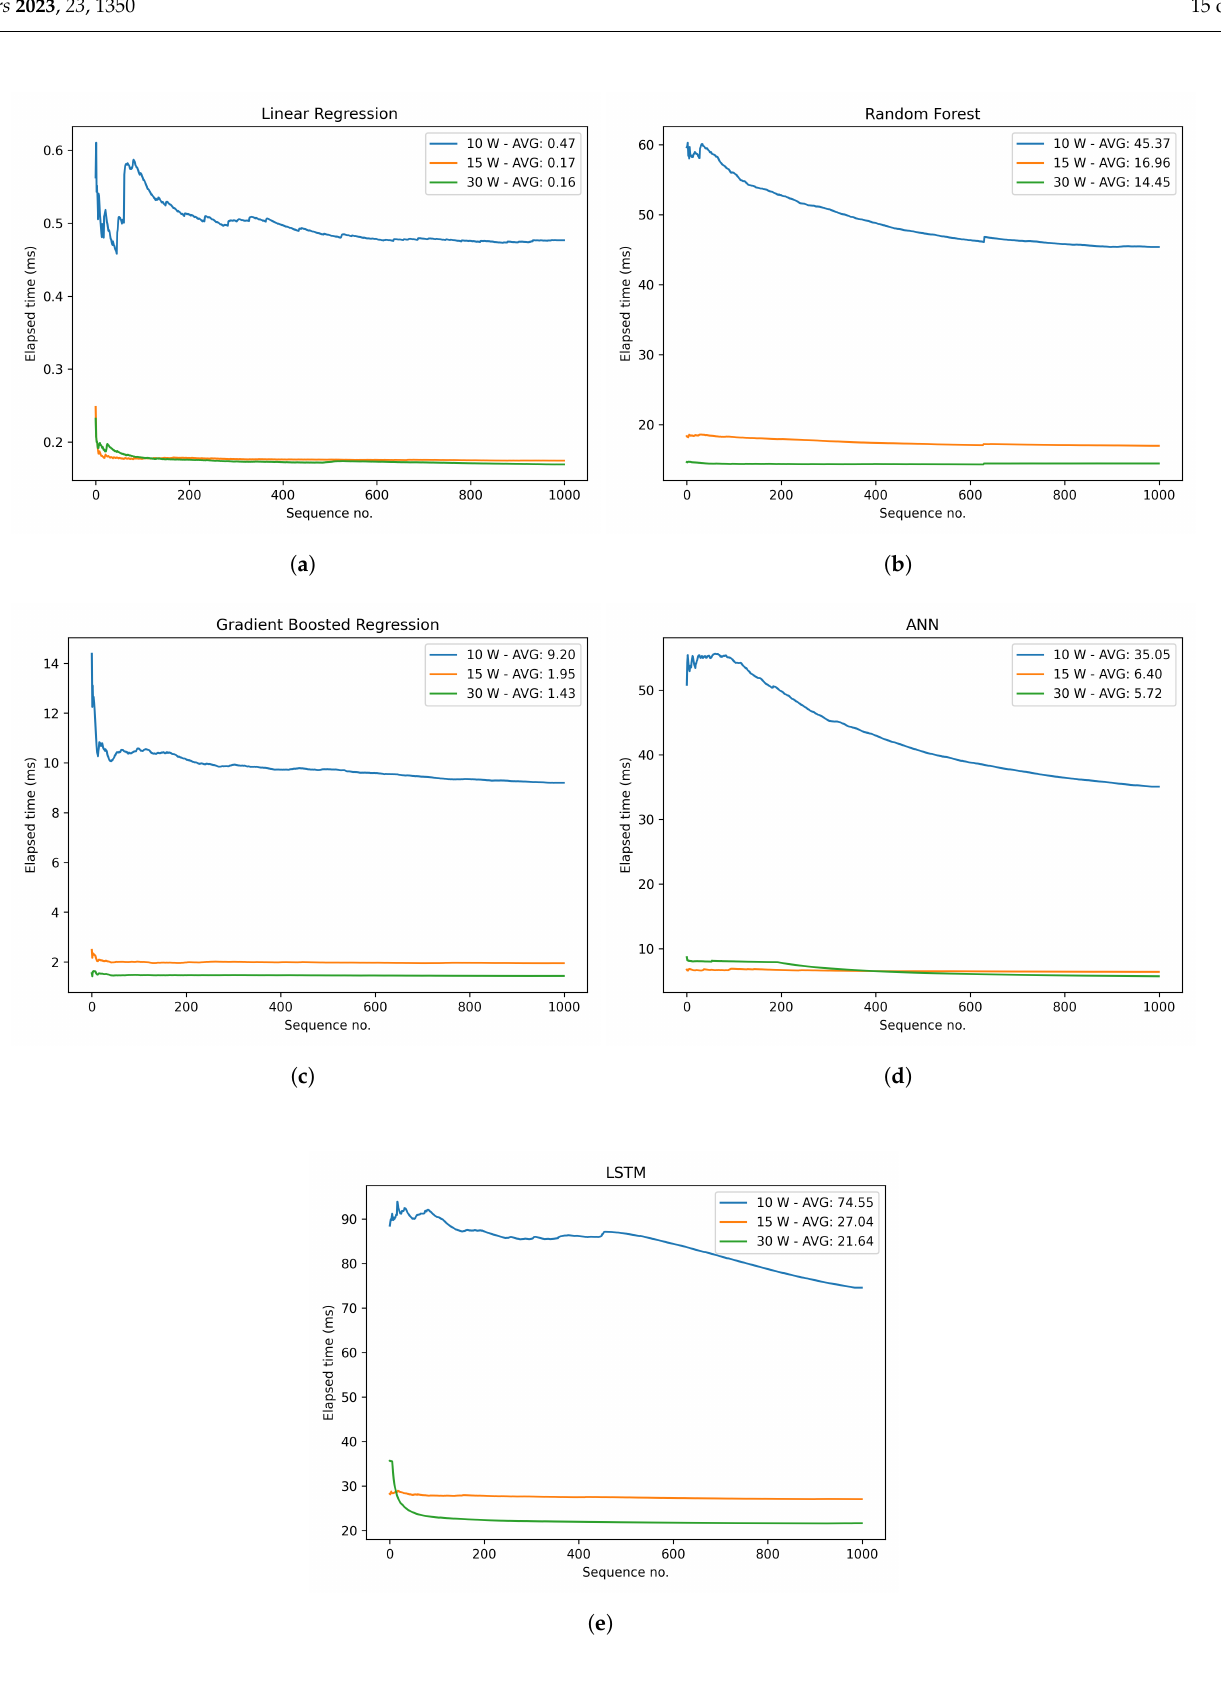
Figure 7. Performance evaluation. ( a ) Outstanding results in speed. ( b ) Good results at 15–30 W. ( c ) Less than 10 ms for each scenario. ( d ) Good for 15–30 W. ( e ) Achieved real-time for 15–30